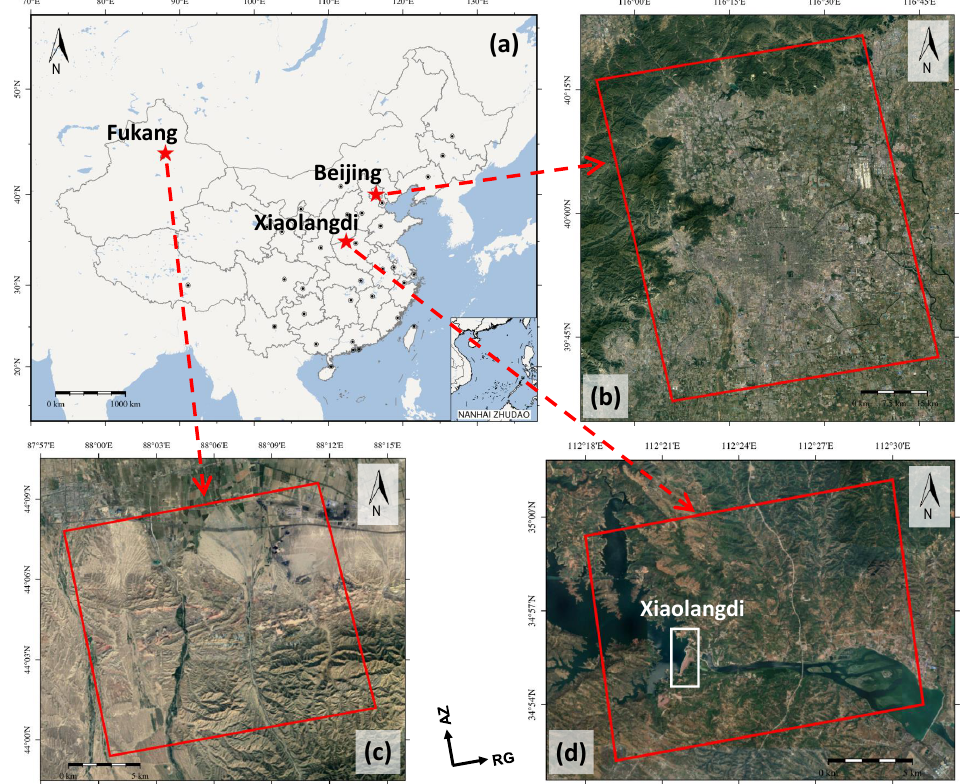
Figure 2. ( a ) Locations of the three test sites. ( b – d ) show the SAR images’ coverage (indicated by the red rectangle) and the GoogleEarth optical image over the Beijing, Fukang, and XiaoLangDi test site,